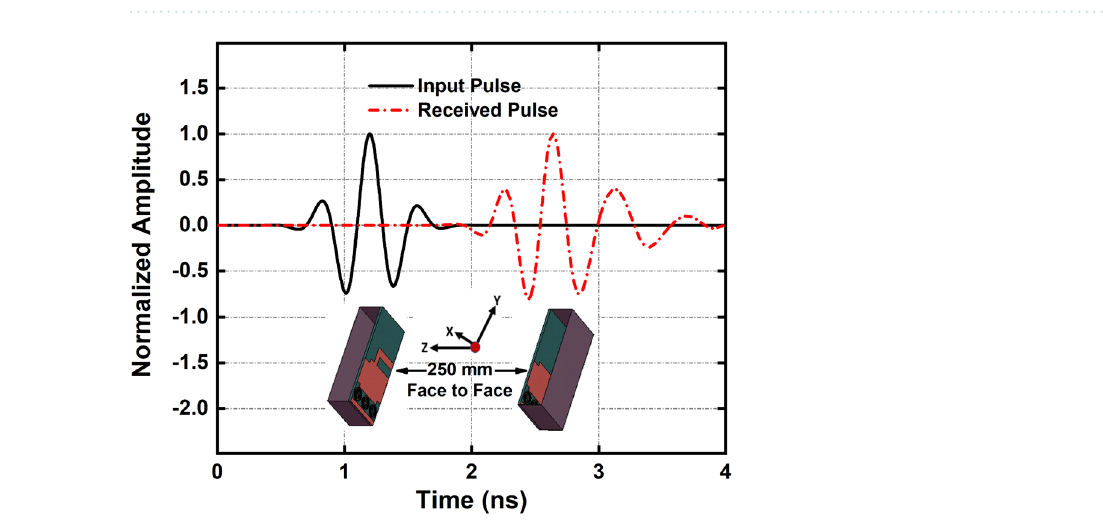
Figure 7. Time-domain performance: Input and received